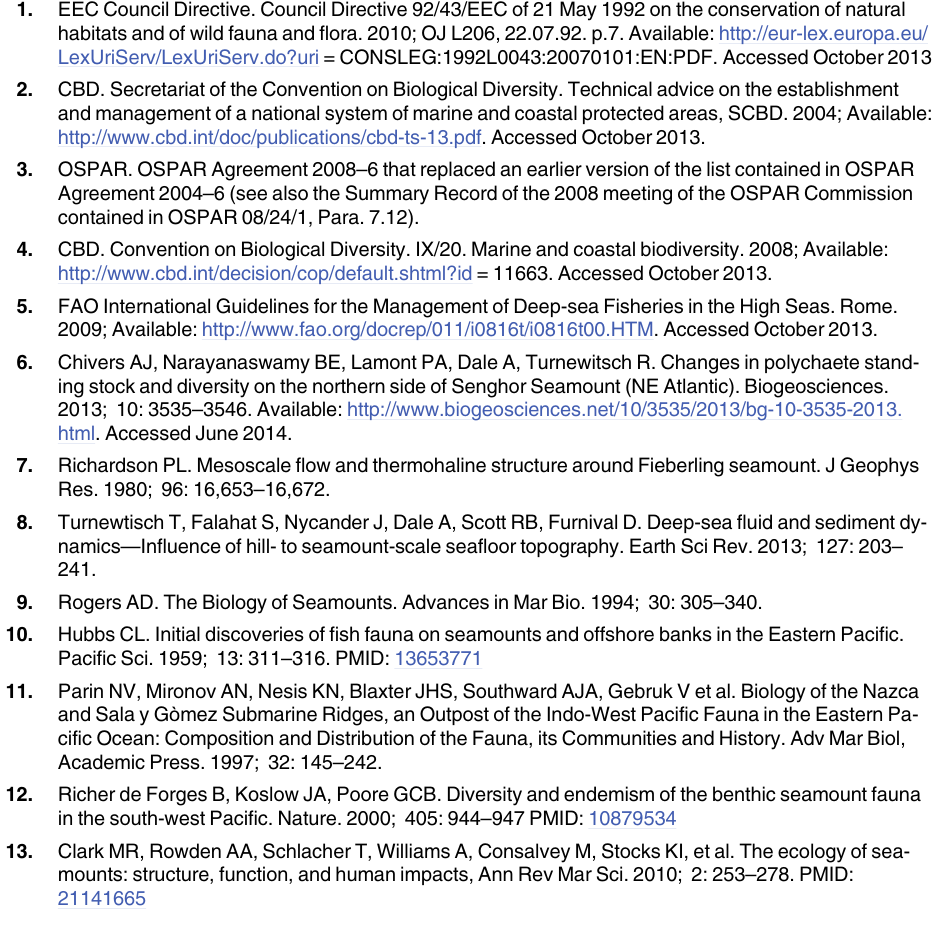
S1 Table. Results of multivariate cluster analysis. Clusters identified using the SIMPROF routine, SIMPER similarity, environmental variables and characterising species for each cluster